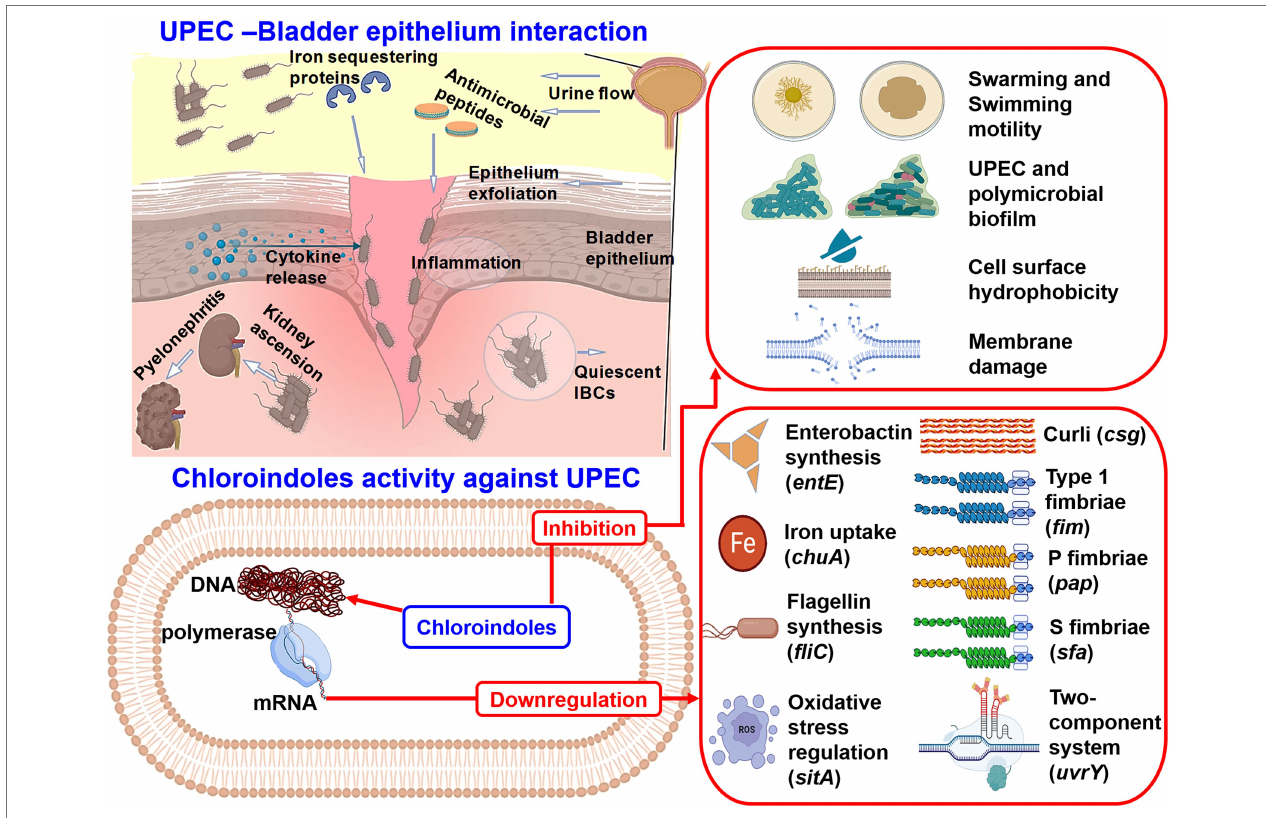
FIGURE 10 | Graphical illustration of the pathogenesis of UPEC, host immune responses, and the antibiofilm and antivirulence activities of 4-chloroindole, 5-chloroindole, and 5-chloro 2-methyl indole against